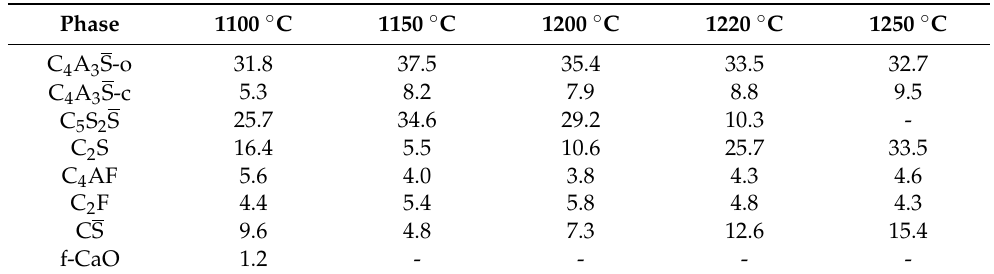
Table 7. Quantitative mineralogical compositions of clinker B sintered at 1150 °C for different re- tention times (wt.%).